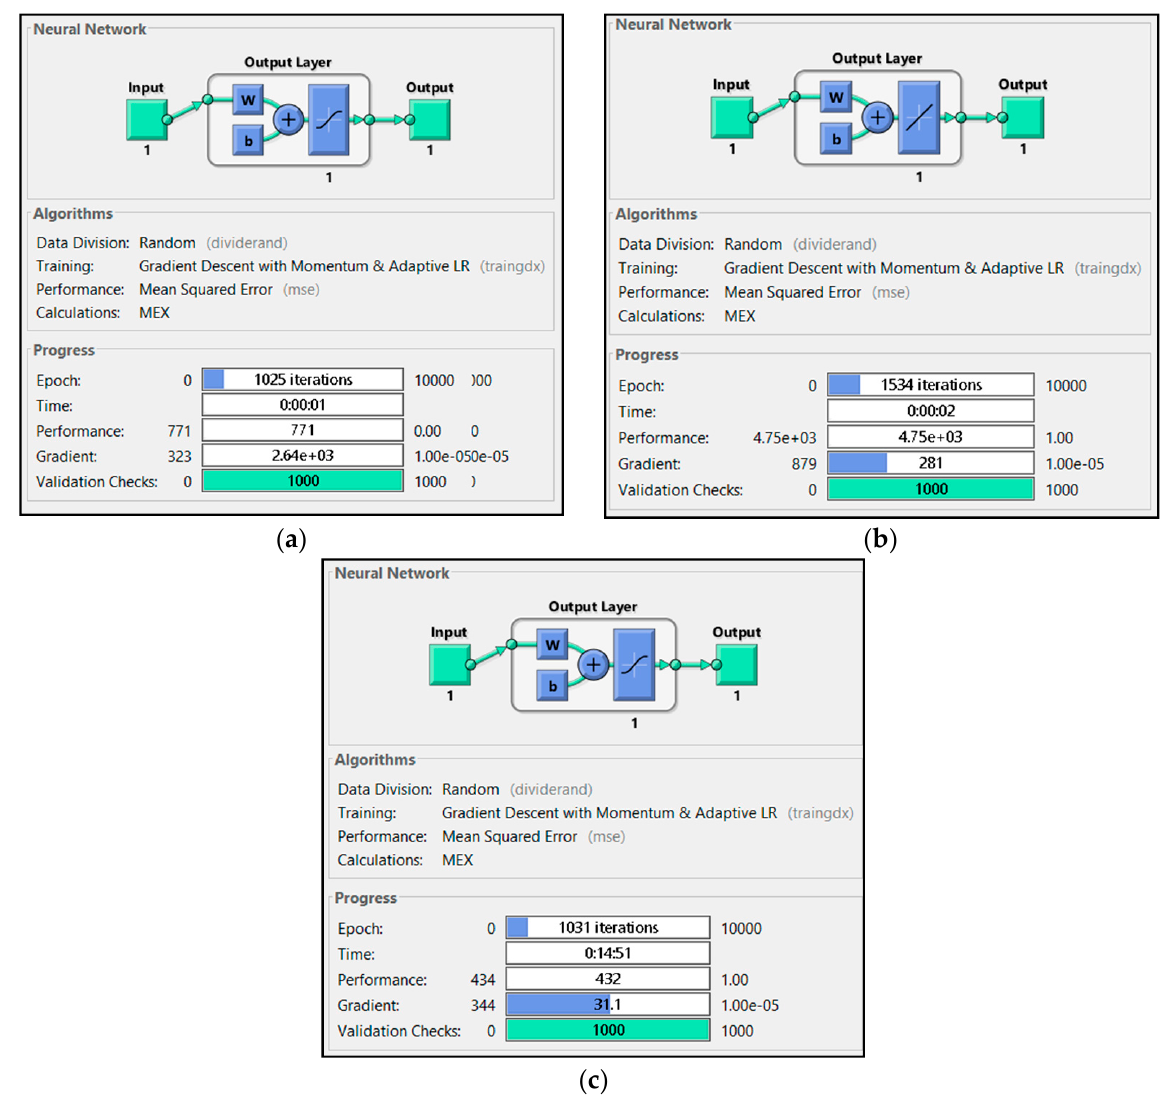
Figure 5. Training results of ( a ) P1, ( b ) P2 and ( c ) P3.